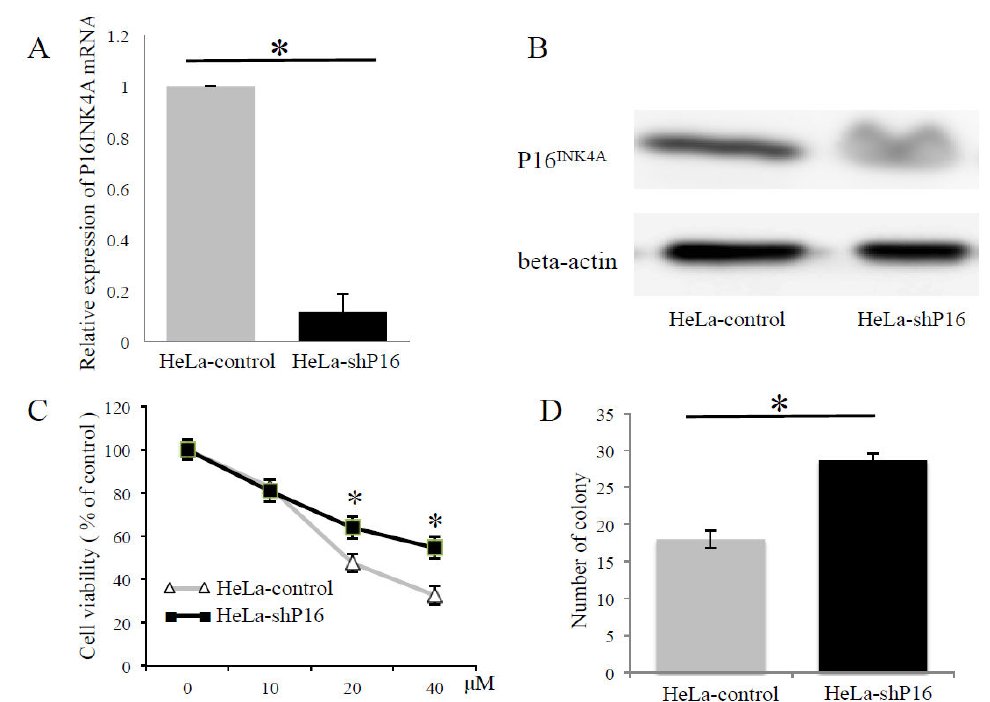
Figure 4. Depletion of P16 INK4A increased the resistance to cisplatin and irradiation of cervical cancer cells. ( A , B ) P16 INK4A expression was down-regulated after pTGMP-p16/p19.478 (HeLa-shP16) transfection. The inhibition of P16 INK4A mRNA and protein expression reached 88% and 41%, respectively. Beta-actin was used as a control for RT-PCR and western blotting. Final data were normalized to it. ( C ) Cell viability was evaluated by the CCK-8 assay in different concentrations of cisplatin. ( D ) After ionizing irradiation (6 Gray), cell survival was detected by colony formation assay. The Student’s t -test was used for continuous variables between the two groups. * p < 0.05. Data are presented as the mean ± SD of three independent